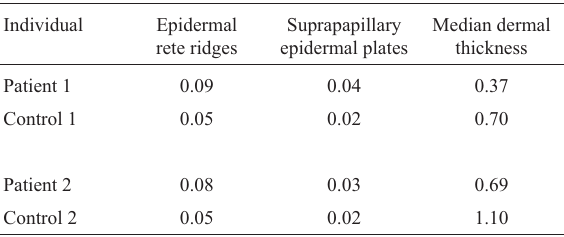
Table 1 - Skin measurements (mm) of patients 1 and 2 compared to controls matched for age, sex and skin